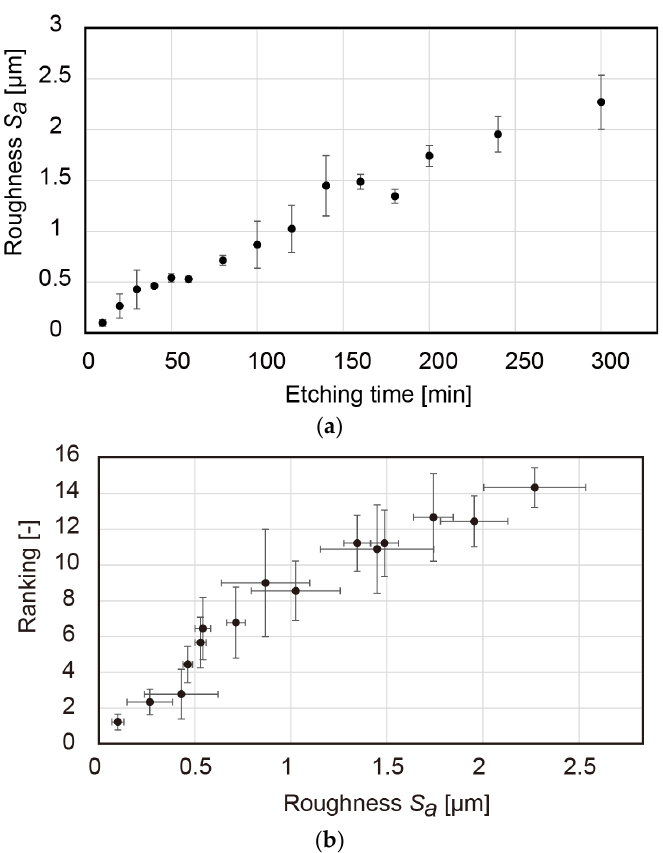
Figure 5. Ranking of dry perception for various etching times.